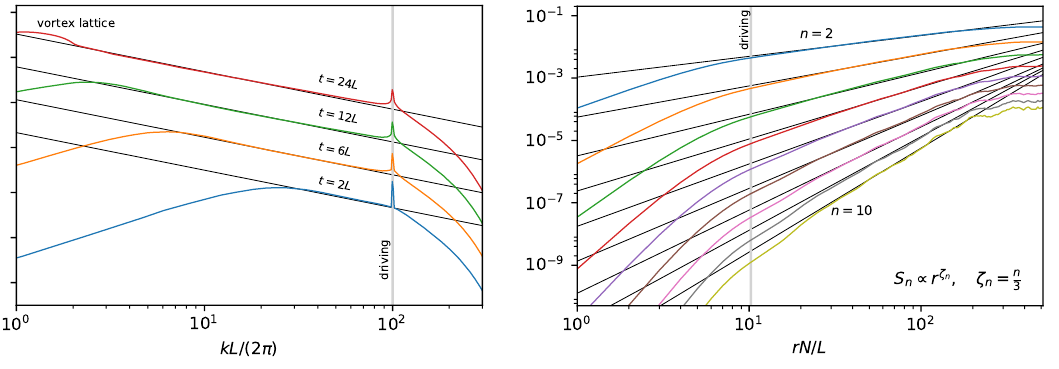
Figure 2 . Left panel : log of the kinetic energy power spectra of a turbulent black brane horizon, averaged over 256 realisations of the F -driving. The normalisation is arbitrary, with the spectra i shown at four different times given different normalisations for clarity of presentation. The inverse cascade is evident as power moves to larger scales over time. The vertical grey line marks the driving scale. The black diagonal lines show the K41 scaling (1.1), k − 5 / 3 , as a guide to the eye. At late times power accumulates at the largest scales on the torus indicating the formation of a vortex lattice structure. Right panel : longitudinal structure functions of a turbulent black brane horizon, averaged over 256 realisations of the F -driving, shown at t = 14 L . The straight black lines show i the K41 scaling relations (1.2) for the longitudinal structure functions up to n = 10 . The vertical grey line indicates the wavelength of the